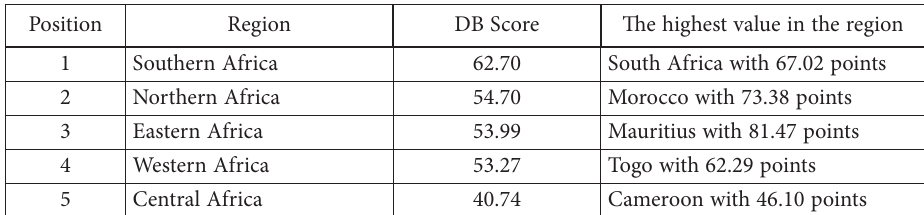
Table 1. The Doing Business scores at regional level (source: own calculation based on The World Bank, 2020a) Position Region DB Score The highest value in the region 1 Southern Africa 62.70 South Africa with 67.02 points 2 Northern Africa 54.70 Morocco with 73.38 points 3 Eastern Africa 53.99 Mauritius with 81.47 points 4 Western Africa 53.27 Togo with 62.29 points 5 Central Africa 40.74 Cameroon with 46.10